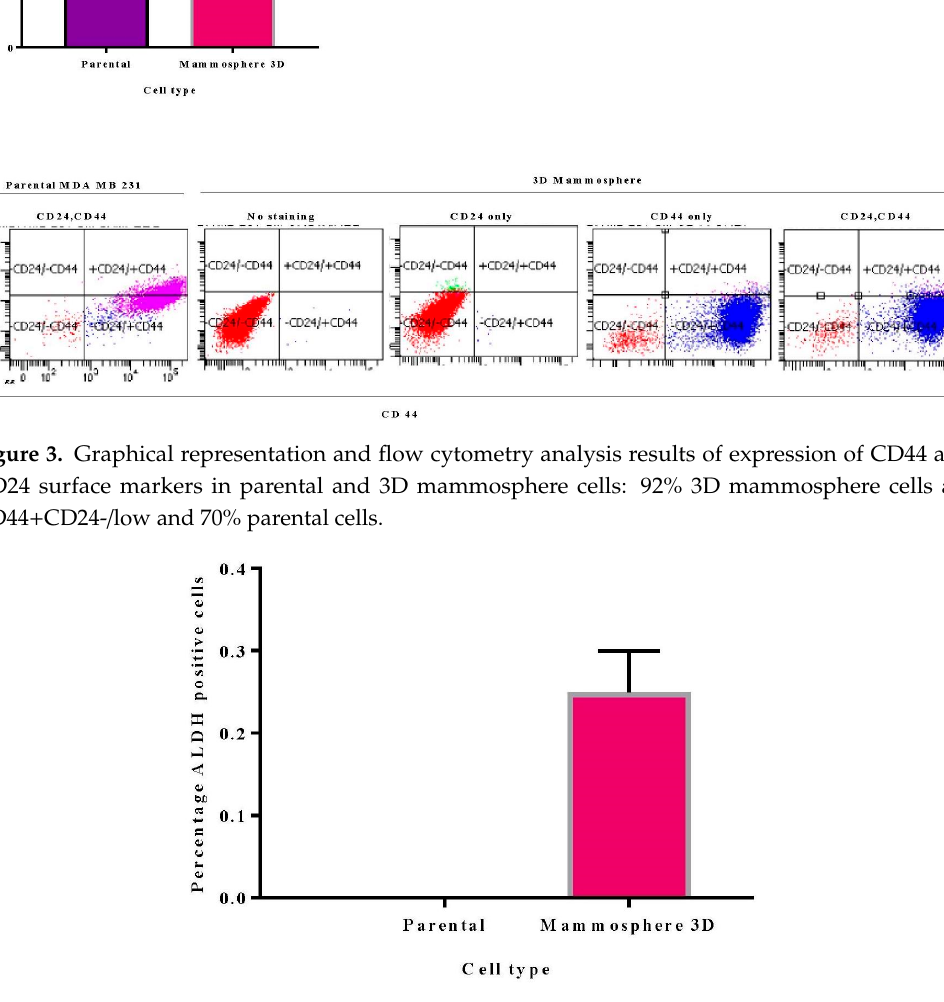
Figure 4. Graphical representation of ADLH activity in parental and 3D mammosphere cells.